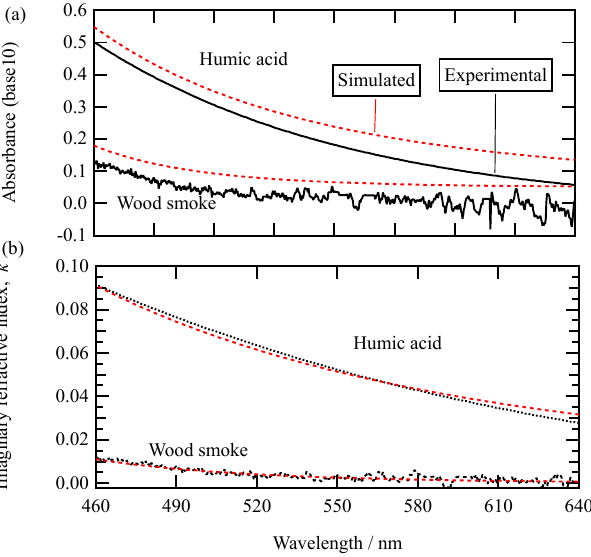
Figure 3. The absorbance (base 10) of the aqueous humic acid so- lution and woodsmoke aerosol in isopropanol. The mass density of humic acid in water is 7 . 00 × 10 − 5 gcm − 3 , and the mass density of the woodsmoke extract in isopropanol is 6 . 60 × 10 − 5 gcm − 3 . Using mass densities of pure humic acid (1.52gcm − 3 ) and woodsmoke extract B (1.64gcm − 3 ) allows calculation of the imag- inary refractive index of the pure components as displayed in panel (b) . The simulated absorbance curves displayed in the figure are calculated using Eq. (2), using parameters contained in Table 2. The simulated absorbance curves in panel (a) have been displaced upwards for